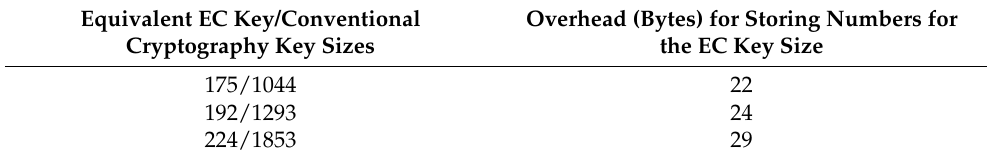
Table 4. EC-based vs. conventional crypto key sizes and resulting